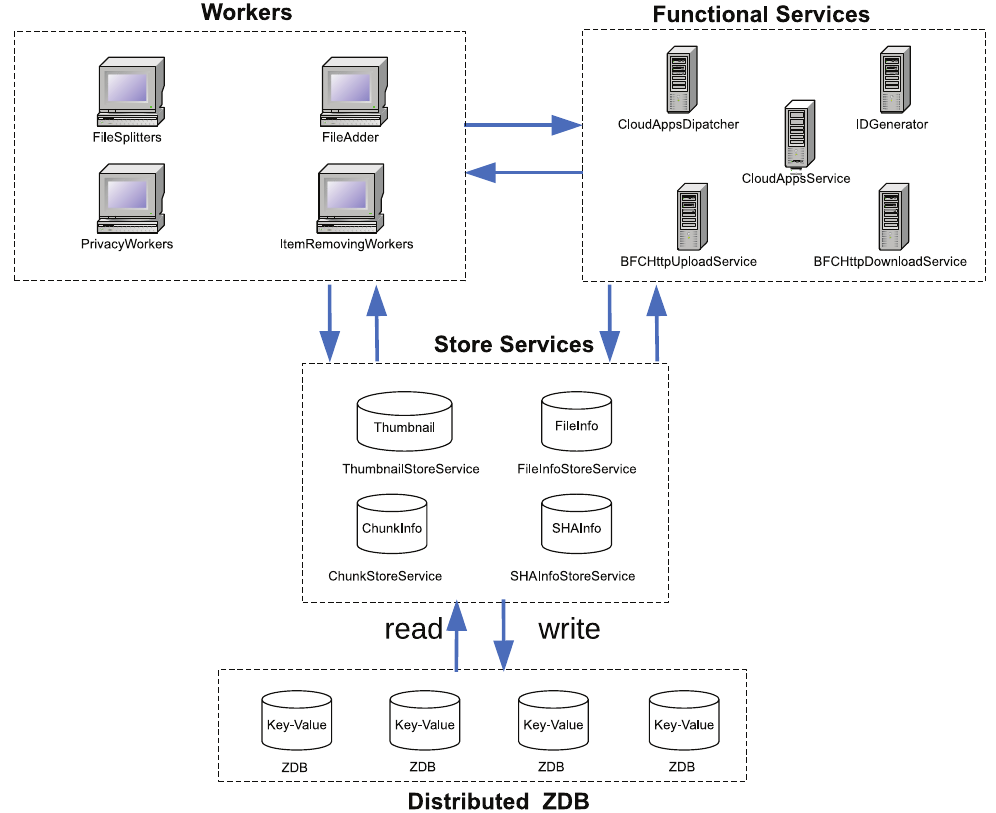
Fig. 2. BFC Main Backend